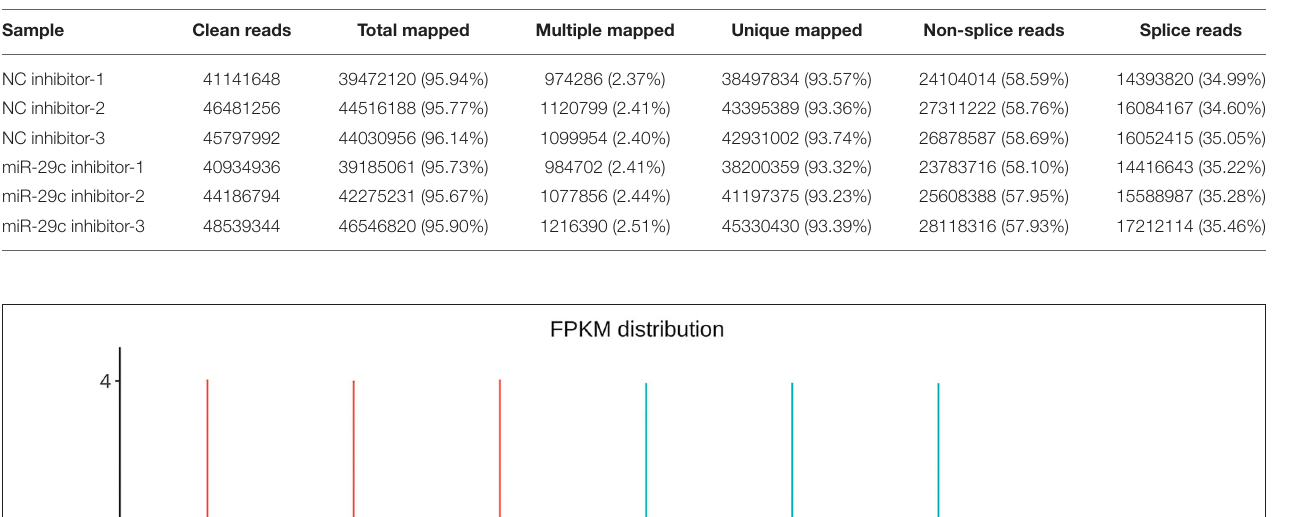
TABLE 2 | Overview of reads mapped to reference genome.